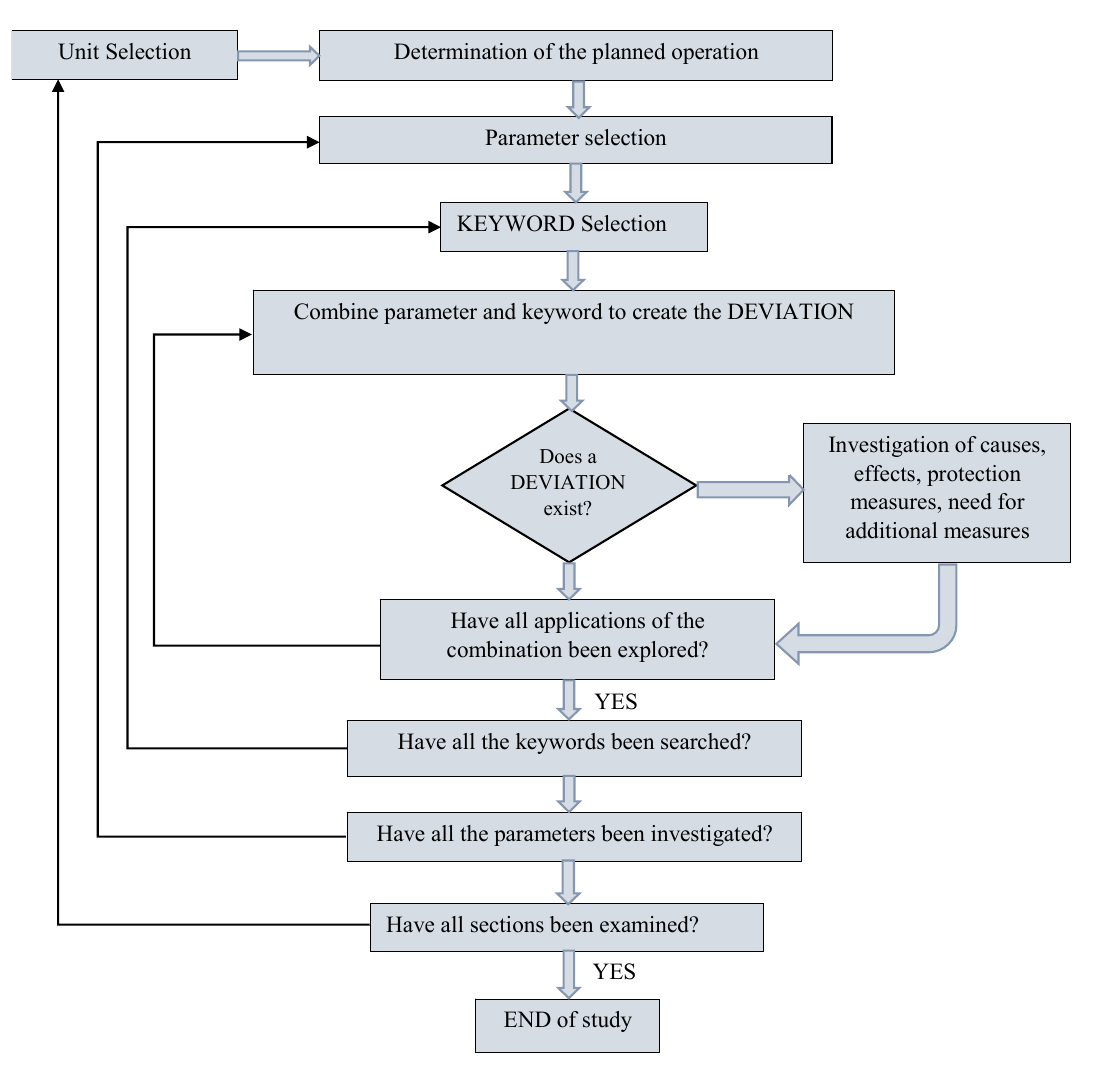
Figure 1. Depiction of the HAZOP flow-chart, used in the HAZOP study of a SCOPI and of an MRS/GTS station.